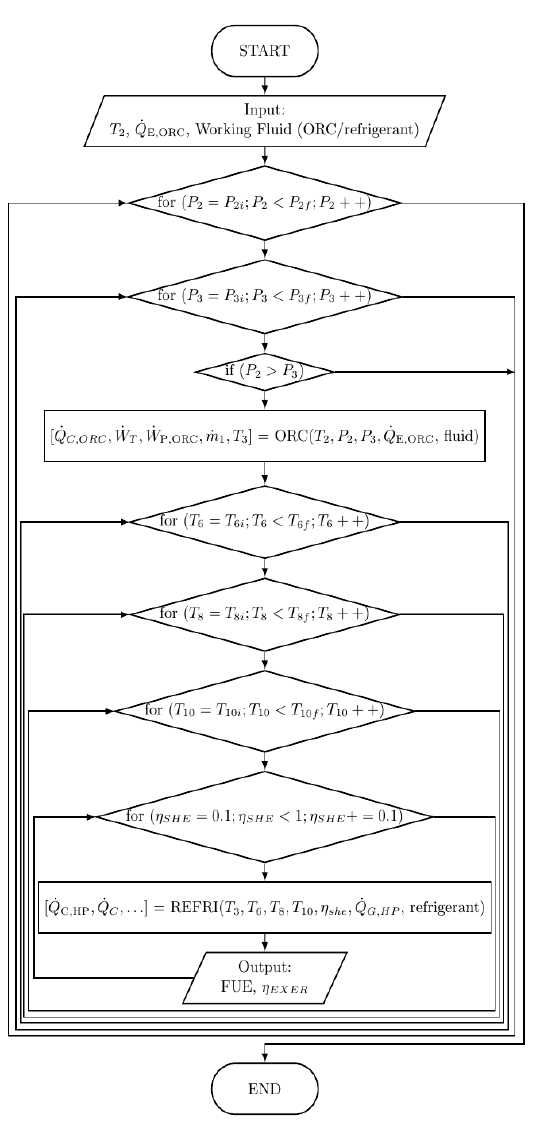
Figure 2. Code fl owchart for the mathematical model solution. Figure 2. Code flowchart for the mathematical model